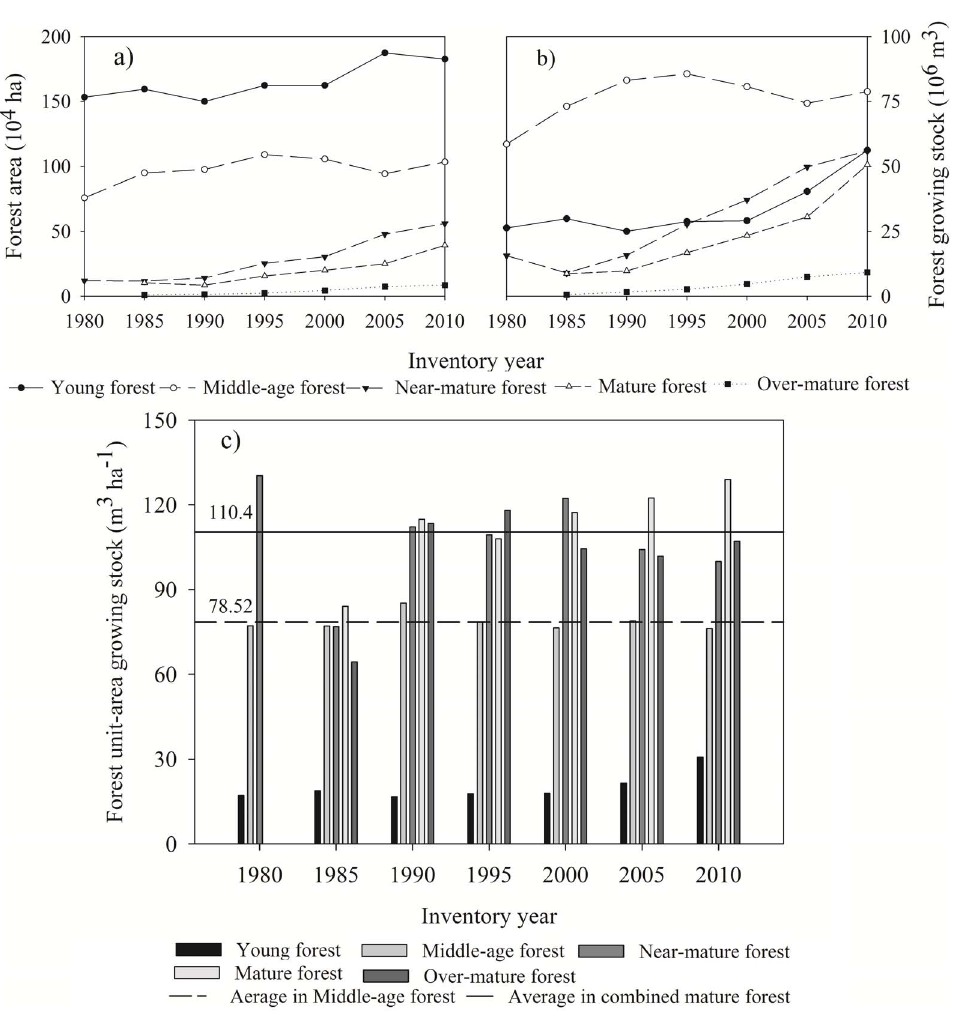
Figure 3. Trajectory of (a) forest area; (b) growing stock; and (c) unit-area growing stock by age class in Liaoning province from 1980 to 2010. Combined mature forest includes near-mature, mature and over-mature